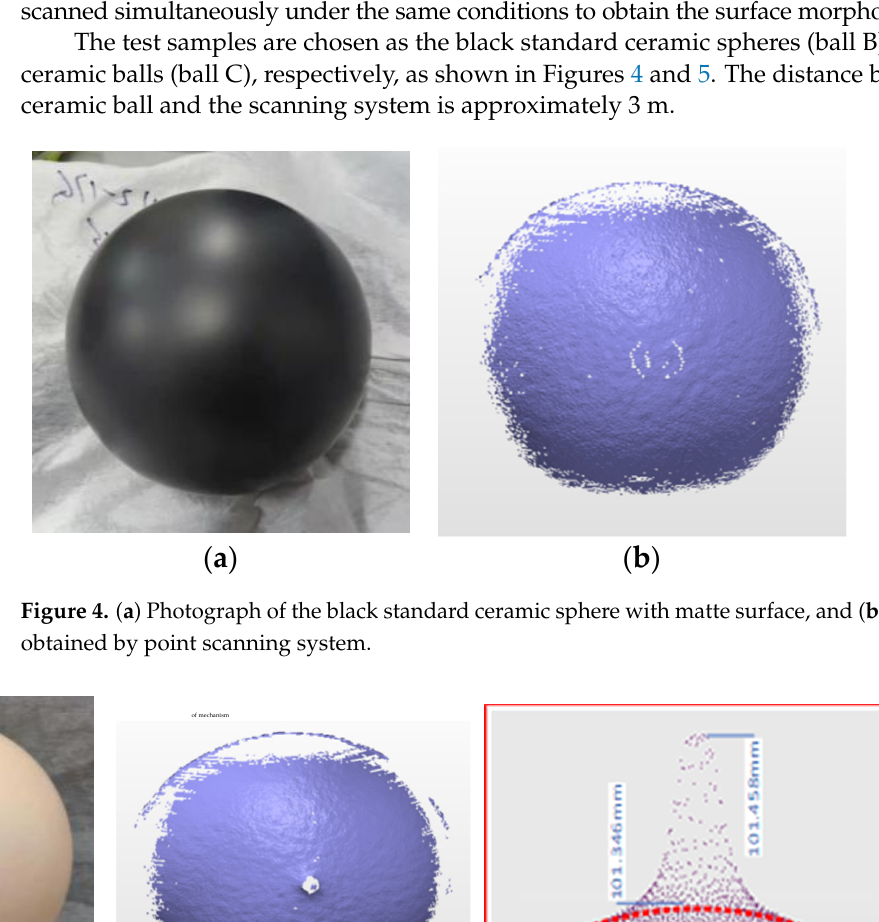
Figure 4. ( a ) Photograph of the black standard ceramic sphere with matte surface, and ( b ) point cloud obtained by point scanning system.